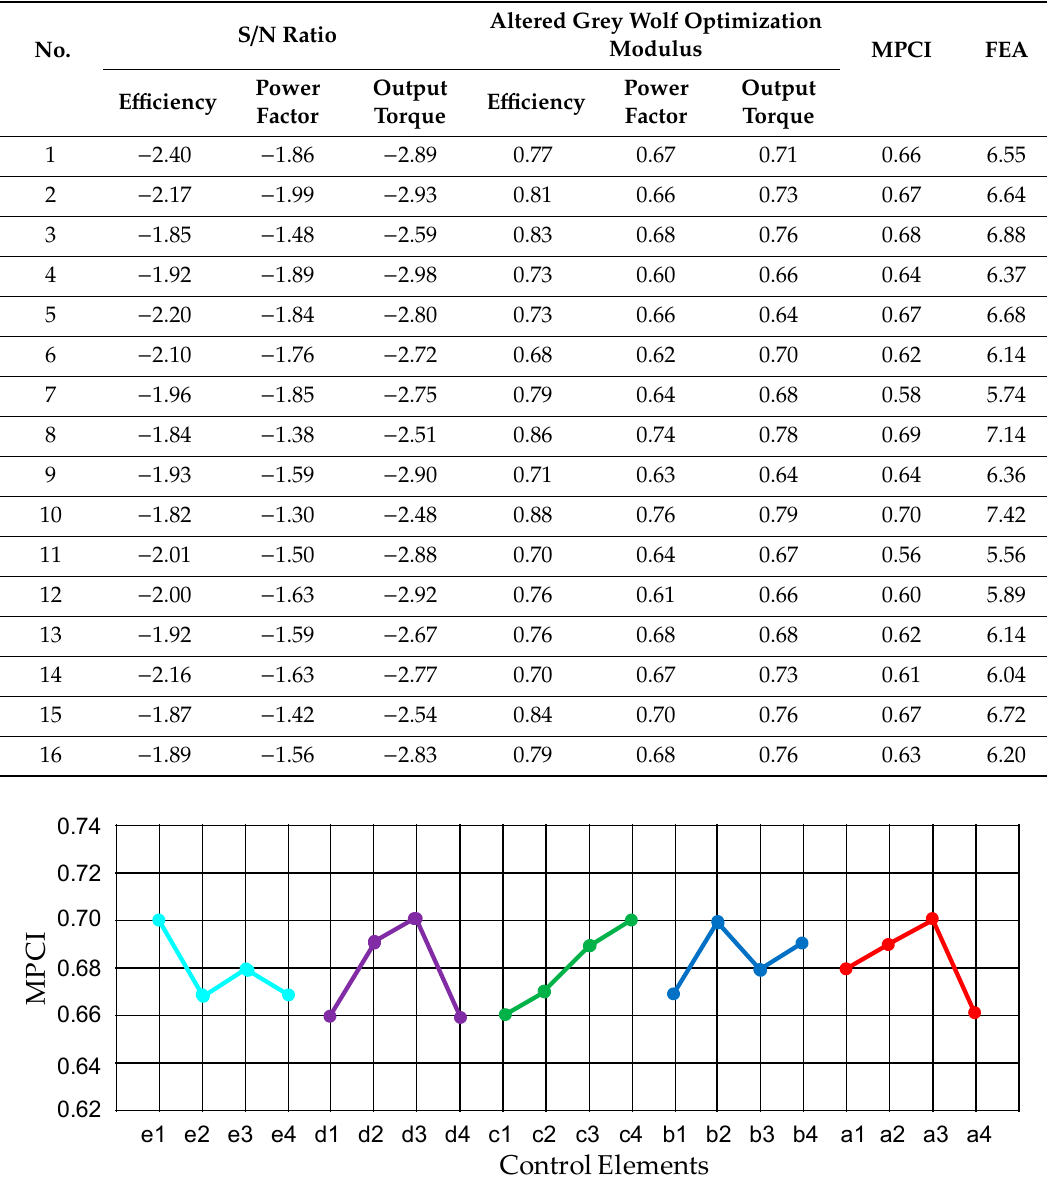
Table 5. Conversion array of S / N ratio, altered grey wolf optimization modulus and MPCI.